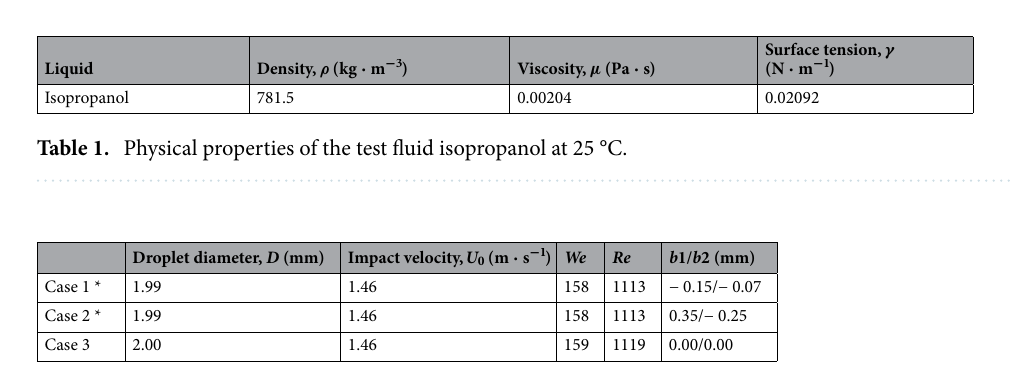
Table 2. Impact parameters for droplet impact onto a surface with a 1 mm × 1 mm × 1 mm cubic pillar. In all cases full wetting conditions are satisfied. Both numerical simulations and experiments are done for the Case 1 and Case 2. Case 3 is conducted only with the numerical simulation. *Experimental; uncertainty ( 2 σ ): D ± 3.8% , U 0 ± 1.3%